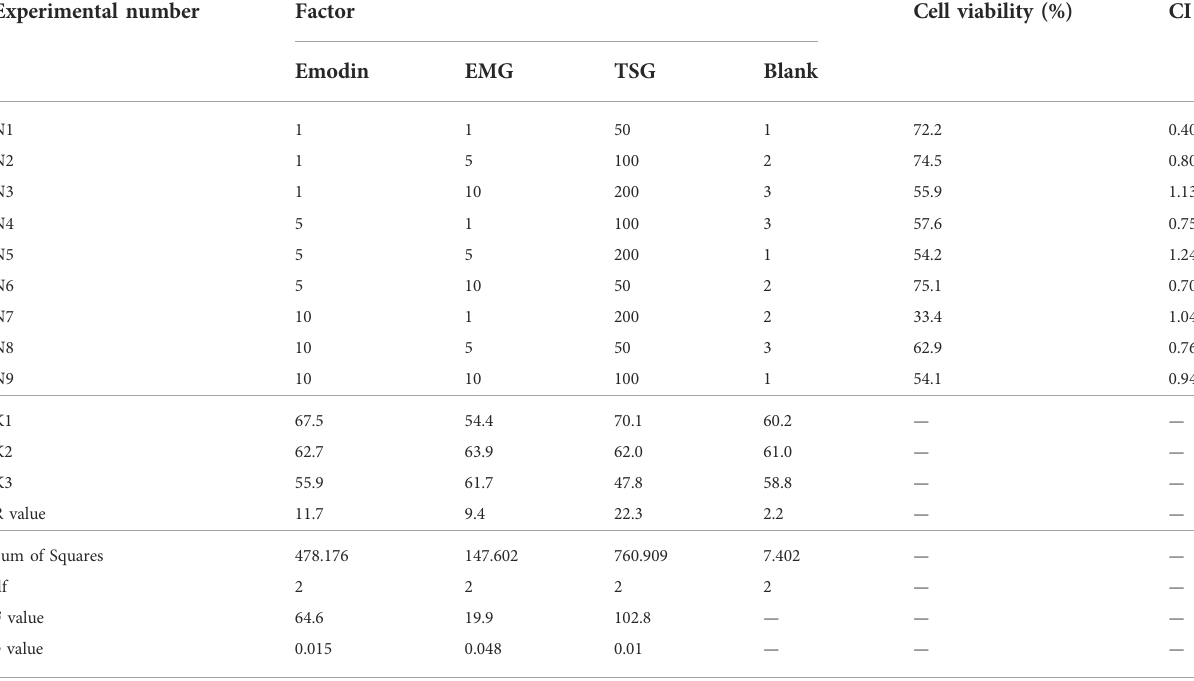
TABLE6Orthogonaltestresults,rangeandone-wayANOVAanalysis,andCIforthreecharacteristiccomponentsofPMinL02cell( n =3independent repeated experiments). Experimental